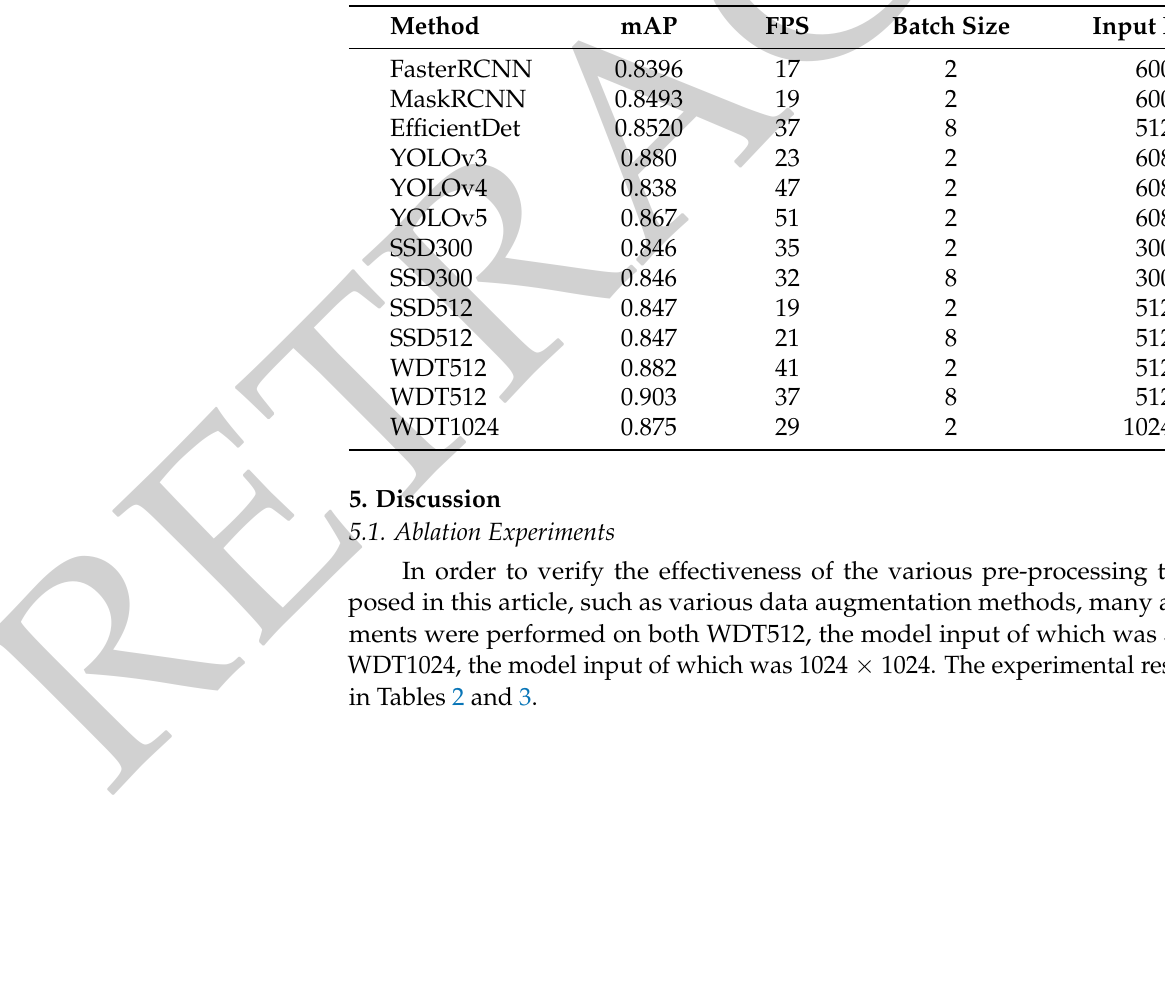
Table 1. A comparison of other models and our